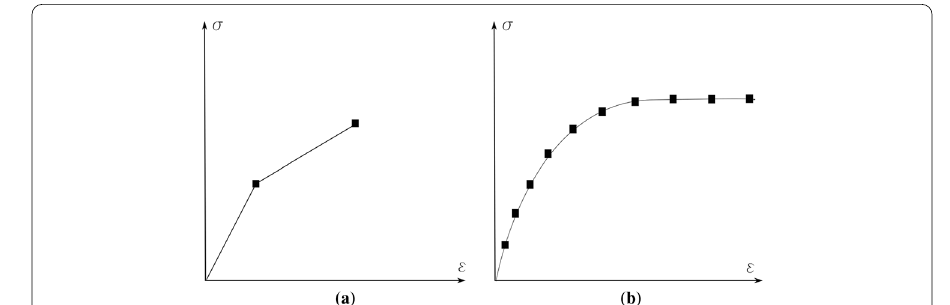
Fig. 1 Stress–strain relationships: a bilinear; b piecewise linear